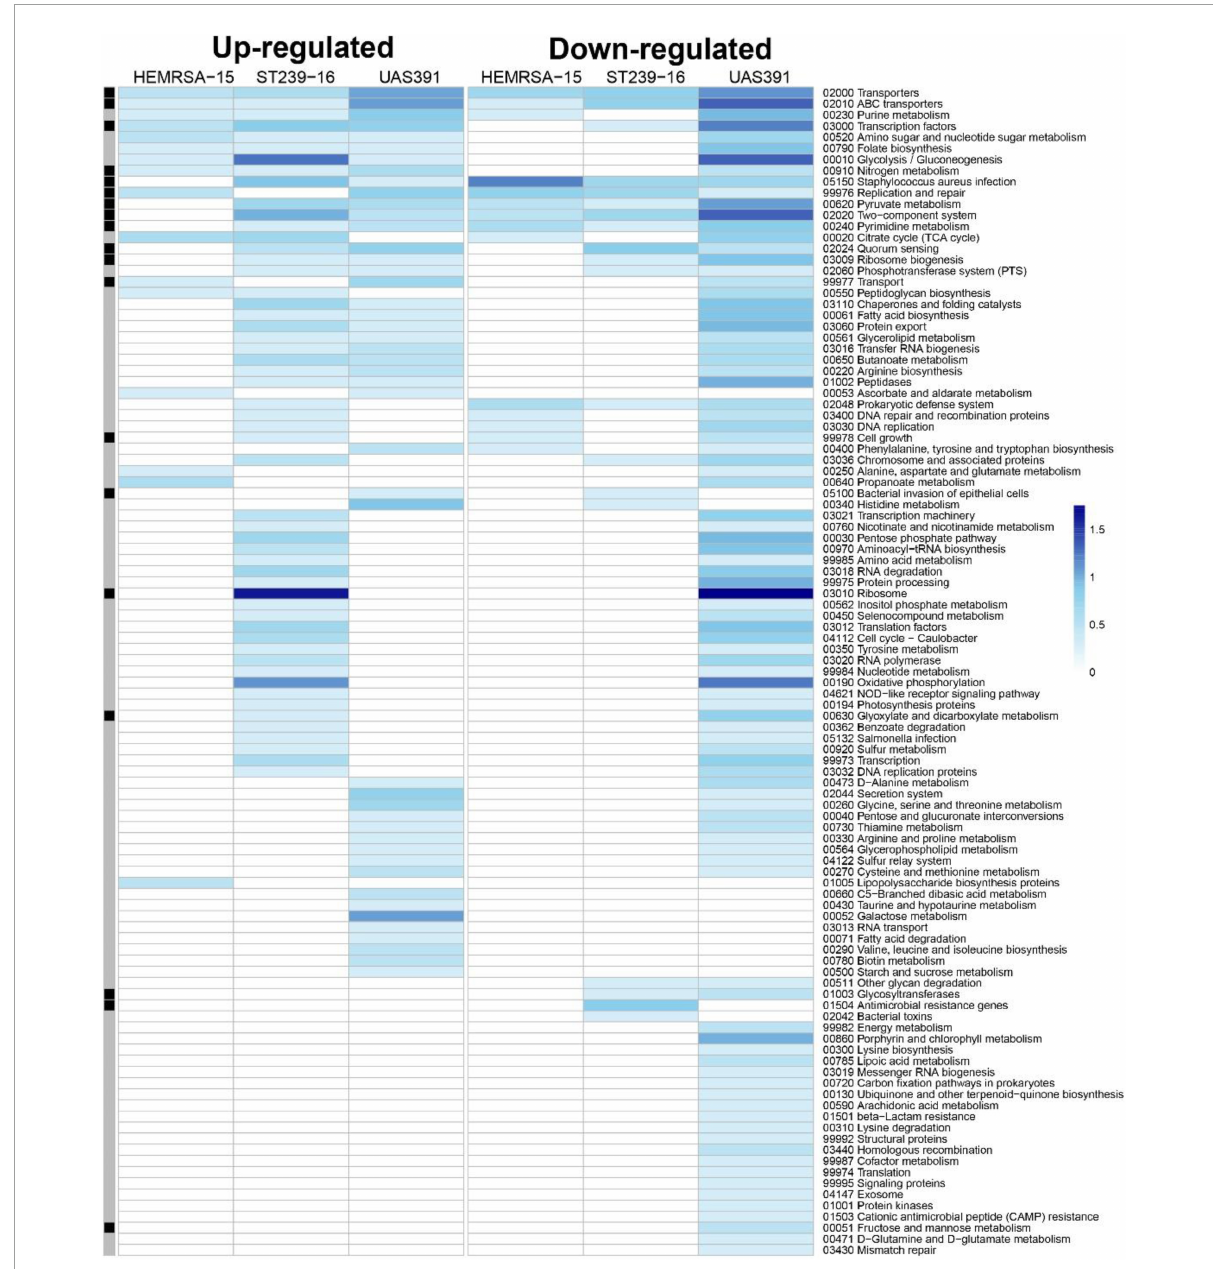
FIGURE2 Gene expression analysis of 48-h biofilm and planktonic phenotypes in three representative MRSA strains: HEMRSA-15 (left), ST239-16 (middle), and UAS391 (right). Metabolic pathway signatures of biofilms compared to planktonic bacteria after 48 h of growth. Identified DEGs were mapped against the KEGG database to obtain KO terms and associated metabolic pathways. Color-coded cells represent the number of enriched genes [log 10 (1 + number of enriched genes)] in the respective KEGG pathway in accordance with the color scale. Black–gray marking indicates whether some enriched genes in the KEGG pathway are linked to the accessory genome (black) or not (gray). Two biological repeats were used for each phenotype in each strain across time